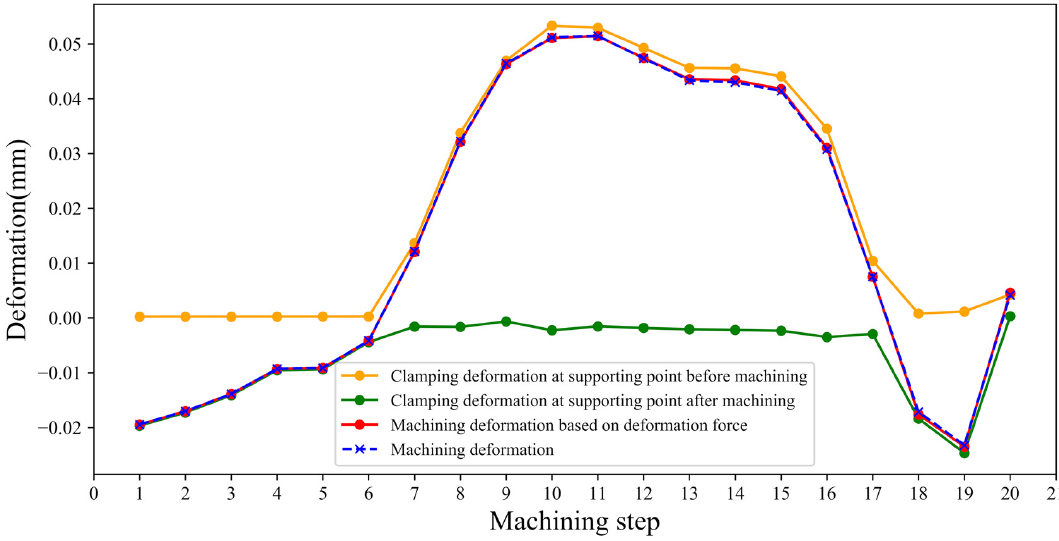
Figure 10. Clamping deformation and machining deformation at each machining step.